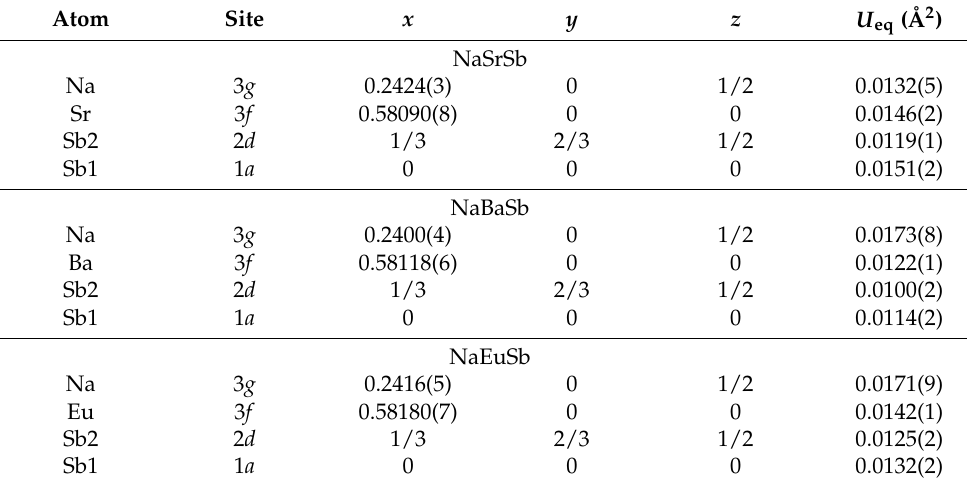
Figure 1. The hexagonal crystal structure of NaBaSb projected down the c -axis. The representation emphasizes the arrangement of trigonal prisms made by Na atoms (red) and Ba atoms (light green), which host the Sb atoms (light blue). The unit cell is outlined and the symmetry-unique atoms are labeled. There are four independent crystallographic positions in the asymmetric unit (Table 2), including one sodium, one barium (or strontium or europium), and two antimony sites, all in special positions. The structure can be described in multiple ways and related to other simpler structures (such as the AlB 2 structure for example) [23]. Table 2. Atomic coordinates of the atoms and their equivalent isotropic displacement parameters U eq a for NaSrSb, NaBaSb and NaEuSb.